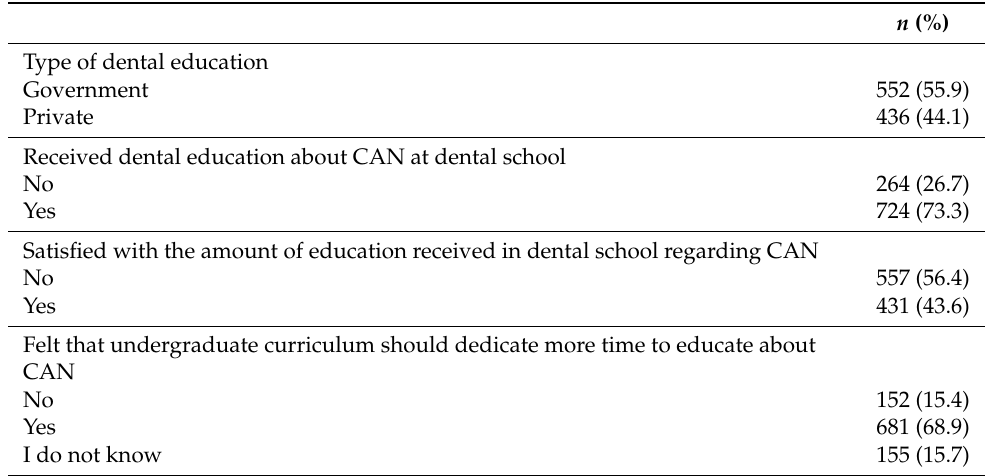
Table 1. Participants’ educational experience regarding CAN † ( n =